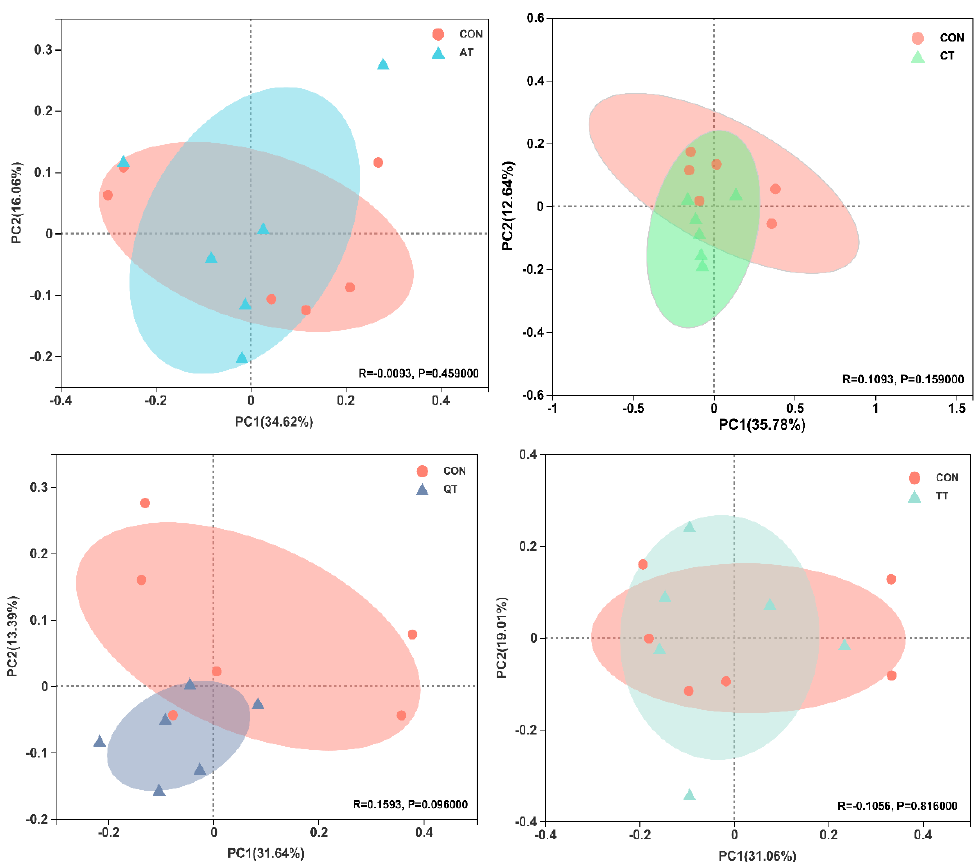
Figure 5. Alpha diversity analysis of gut microbial abundance (Sobs and Chao indices) and diversity (Shannon and Simpson indices) from different groups (n = 6/group); statistical significance was de- termined by Mann–Whitney U test for two-group comparisons. Different letters (a and b) indicate significant differences ( p < 0.05), while the same letter indicates no significant differences ( p > 0.05). CON, control; AT, Acacia mearnsii tannin; CT, Castanea sativa tannin; QT, Schinopsis lorenzii tannin; TT, Caesalpinia spinosa tannin.